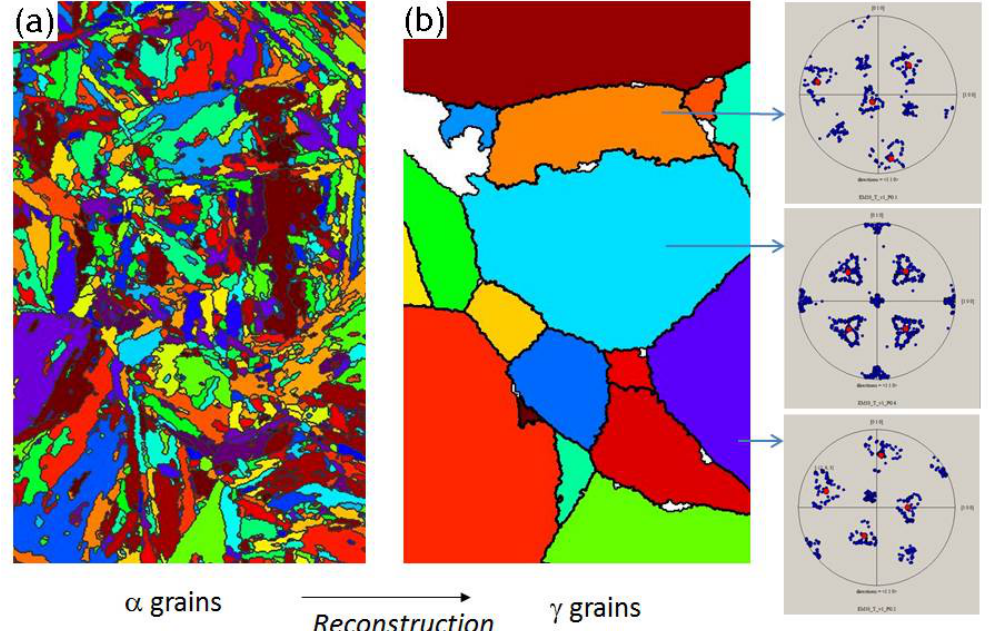
Figure 18. Reconstruction of the parent grains from EBSD maps. ( a ) Initial EBSD map of fully martensitic Fe–0.1C-9Cr–1Mo–0.4Si steel; ( b ) prior parent austenitic grains, reconstructed with the software ARPGE. The orientations of the austenitic grains and those of the martensitic grains they contain are plotted in the pole figures, with the calculated <111> γ directions in red and the experimental <110> α directions in blue.